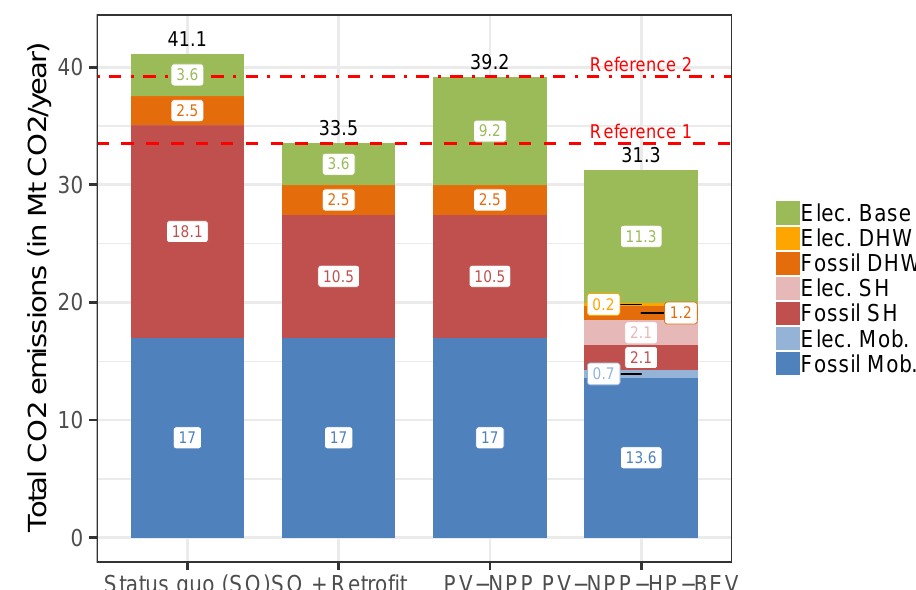
Figure 27. Cumulated CO 2 emissions of the sectors “mobility” (Mob.), “heat” (SH and DHW) and “electricity” (Elec.) in the different scenarios investigated in this study (see Table 2). “Elec. Base” is the base electricity demand (i.e., without the additional electricity demand of heat pumps and BEV). The corresponding sensitivity plot for scenario “PV-NPP-HP-BEV” is displayed in Figure 28. Again the most influential parameter is the CO 2 intensity of the imported electricity (“CO 2 int. imp.”). At a 30% lower CO 2 intensity of imports at 310 g CO /kWh, CO 2 emissions would reach about 2, eq 27.5 Mt CO 2 per year, which is a CO 2 reduction of − 18% compared to “SQ + Retrofit”. In turn, if CO 2 intensities are taken 30% higher at 576 g CO /kWh (current EU mix), CO 2 emissions would total at 2, eq about 35 Mt per year, which is even higher than in the reference “SQ + Retrofit”.